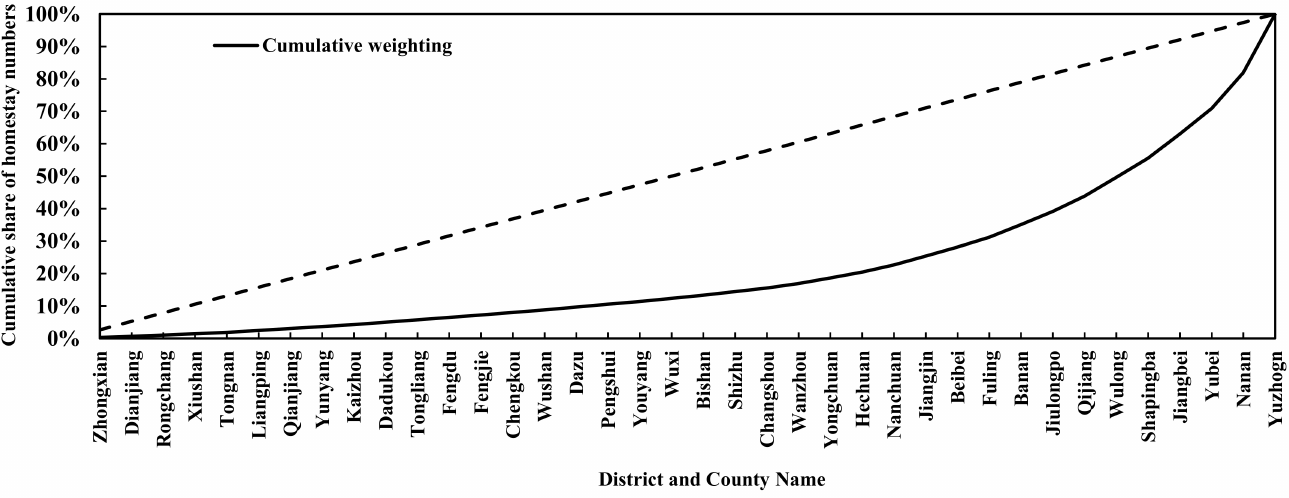
Figure 3. Lorentz curve of homestay distribution in Chongqing.